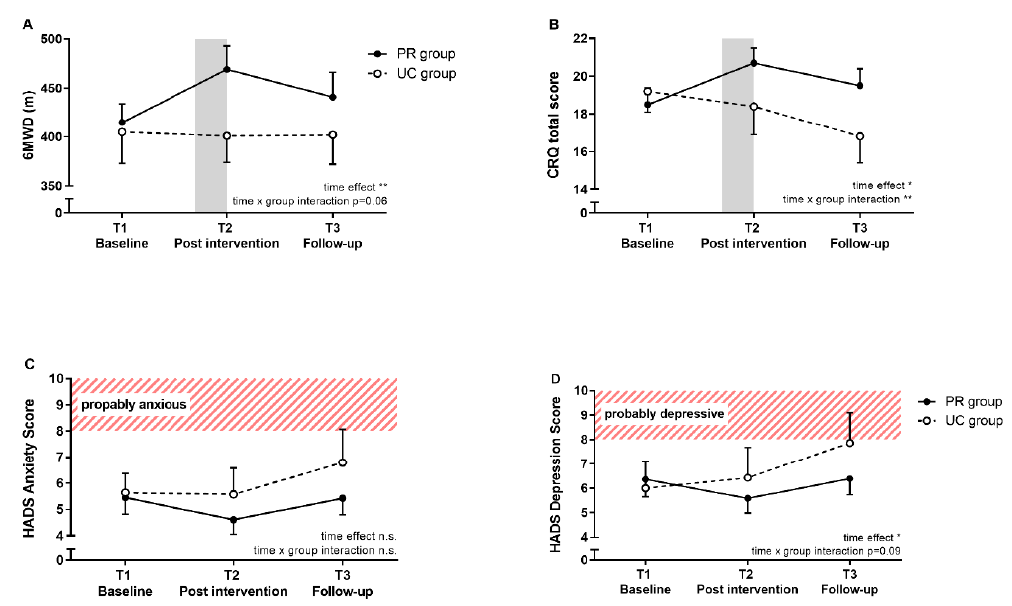
Figure 2. Effects of pulmonary rehabilitation (closed circles) vs. usual care (open circles) on ( A ) 6-min walk distance (6MWD), ( B ) total score in chronic respiratory disease questionnaire (CRQ), ( C ) Hospital Anxiety and Depression Scale (HADS) anxiety score and ( D ) HADS depression score. The grey bar in A and B illustrates the PR or control period of 3 weeks. Patients with HADS scores of 8–10 pts. are assumed to be borderline abnormal (dashed). Data are presented as mean (SE). * p < 0.05, ** p < 0.01.